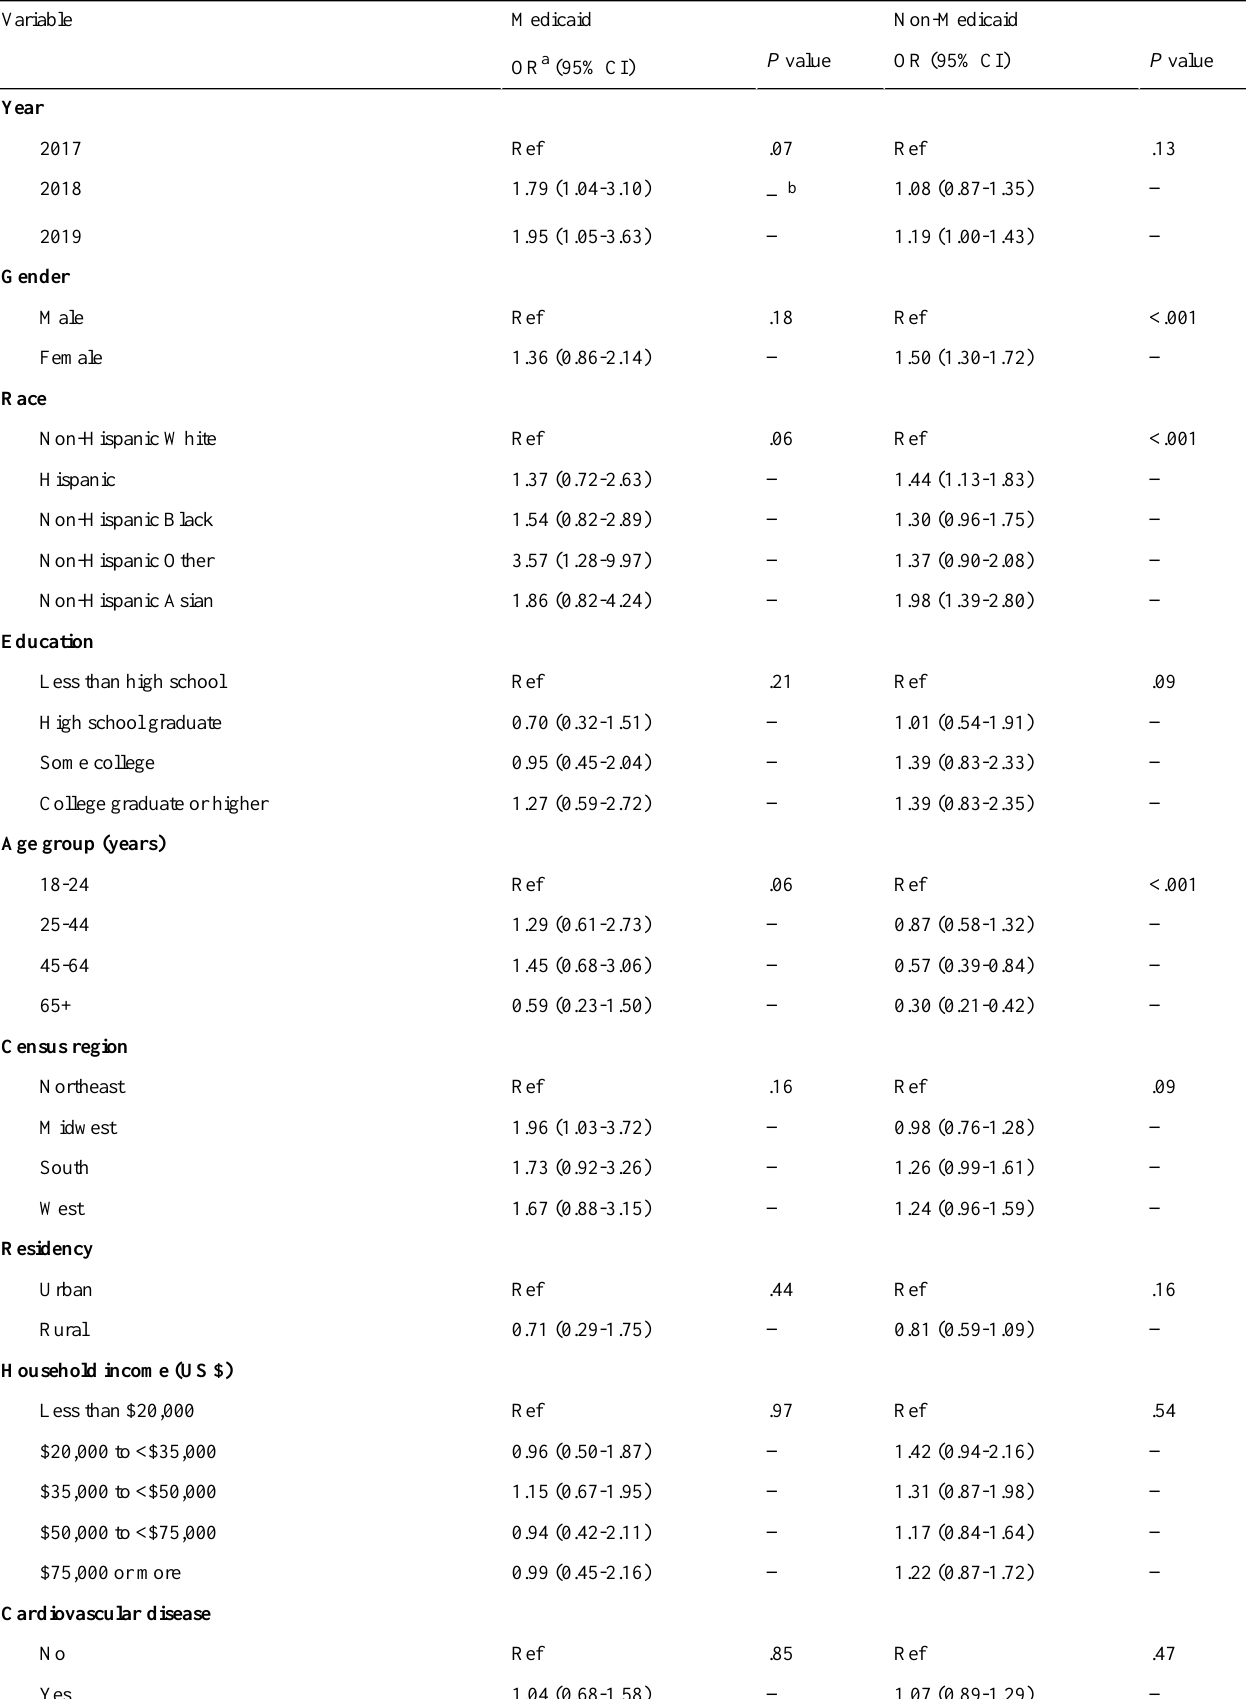
Table 5. The odds ratio of predictors for social media for health information among Medicaid and non-Medicaid participants.